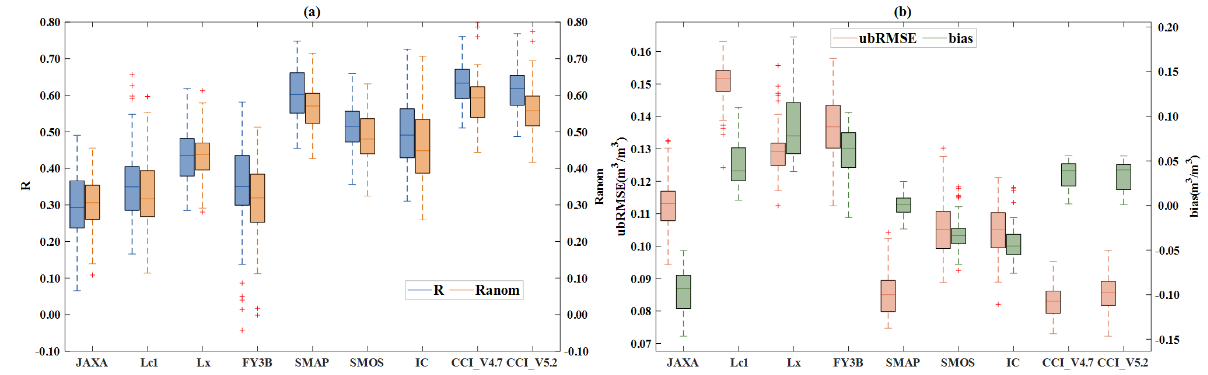
inter-comparison conclusions.